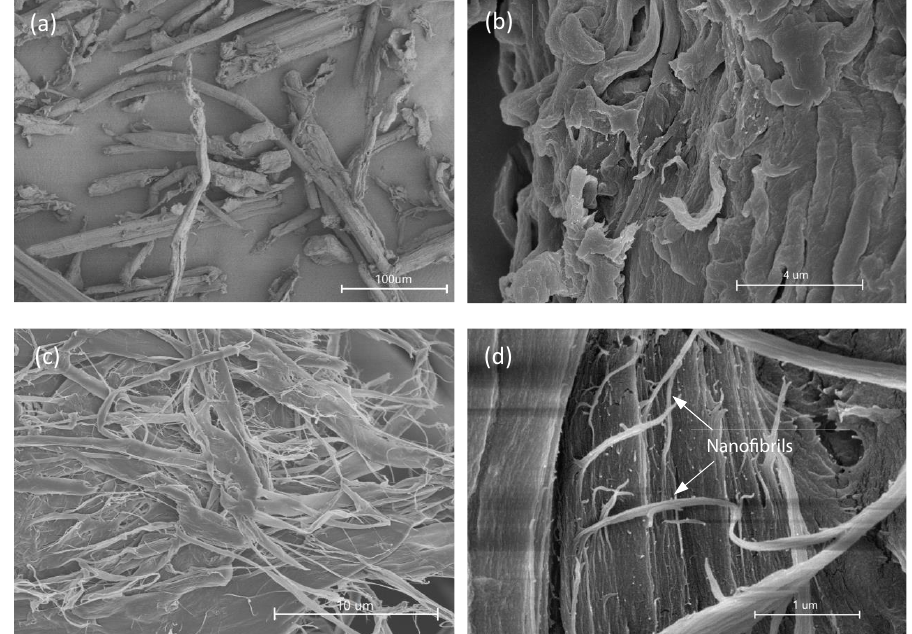
Figure 1: SEM images of ( a ) raw MCC; ( b ) swelled MCC; ( c ) NFC; ( d ) nano fi brils on